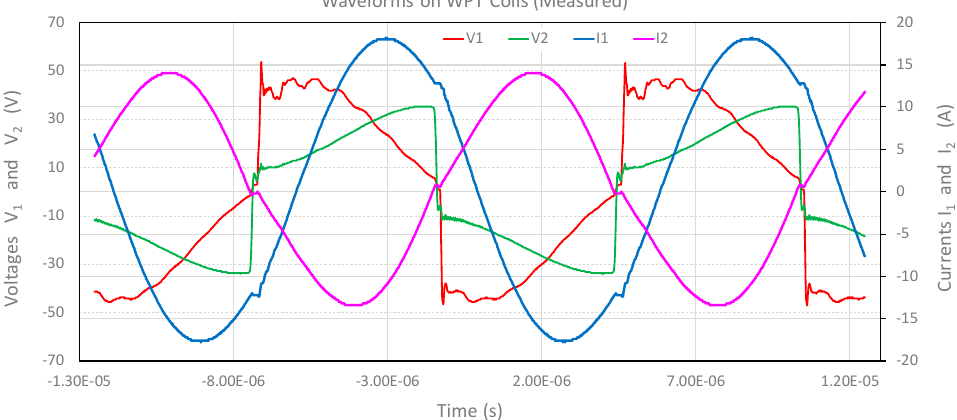
Figure 11. Experimental results of voltages and currents waveforms on the terminals of primary and secondary coils.